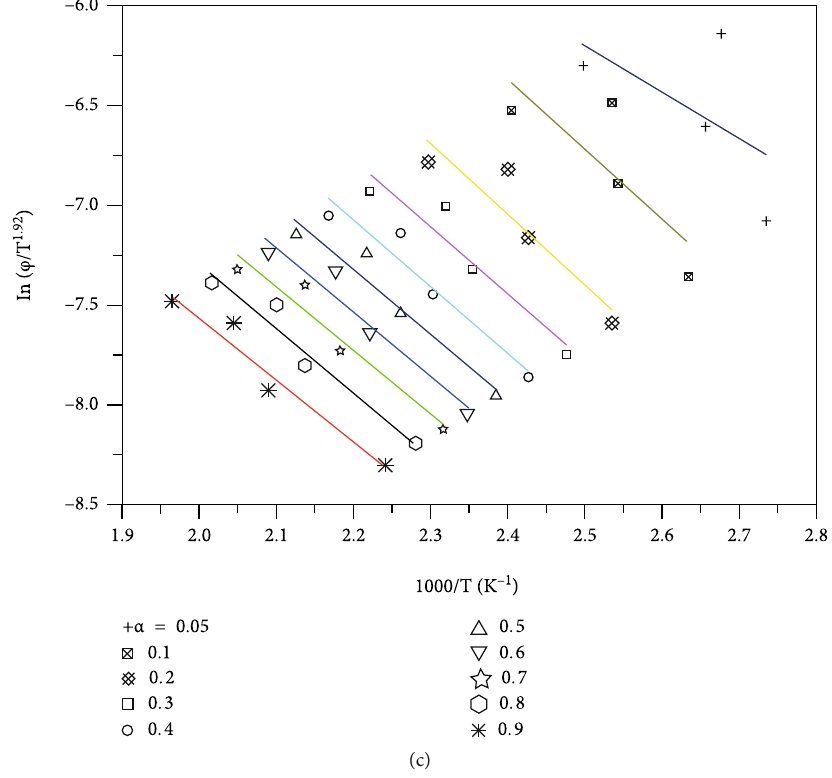
Figure 8: Plots of ln(Ø/T 1.92 ) vs. 1/T for (a) GEP, (b) GELP, and (c) GELNiP nanocomposites based on KAS model.